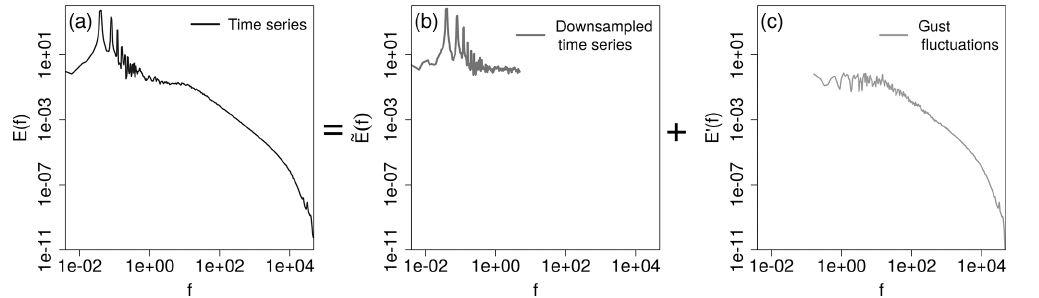
Figure 6. Example of a spectral decomposition of the inverse gust E G ( f ) = ˜ E ( f ) + E (cid:48) ( f ) (a) into its periodic, highly energetic part ˜ E ( f ) (b) and the spectrum of the fluctuations E (cid:48) ( f ) (c) .